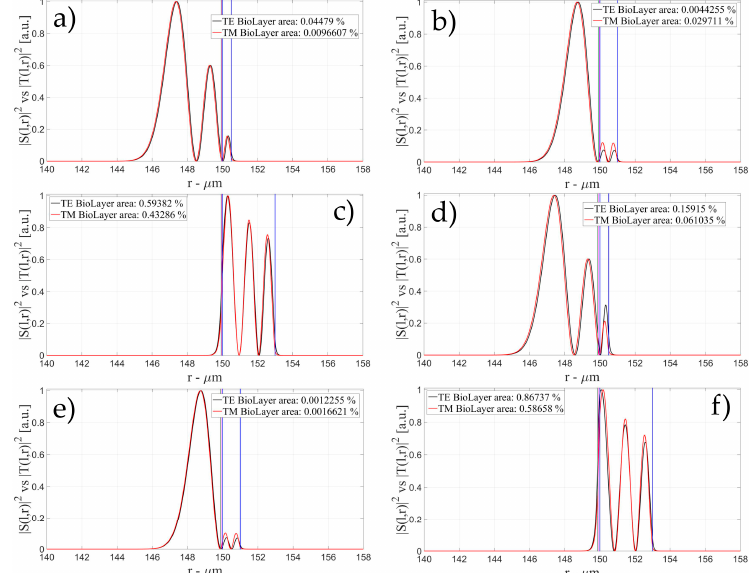
Figure 13. Electric field distribution of WGMs along the radial direction for TE (| S ( l,r ) | 2 ) and TM (| T ( l,r ) | 2 ) modes for the 3rd radial order: ( a ) for a wall of about 500 nm and a polymer thickness of about 50 nm; ( b ) for a wall of about 1 μ m and a polymer thickness of about 50 nm and ( c ) for a wall of about 3 μ m and a polymer thickness of about 50 nm; ( d ) for a wall of about 500 nm and a polymer thickness of about 100 nm; ( e ) for a wall of about 1 μ m and a polymer thickness of about 100 nm and ( f ) for a wall of about 3 μ m and a polymer thickness of about 100 nm. Legends show the fraction of | S ( l,r ) | 2 and | T ( l,r ) | 2 inside the biological layer.